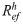
Estimation of Model FD in Period 3 (October/2004—September/2008).(a) observed incidence (O) and adjusted i (E), (b) m3/m, (c) Refh (h) and Refm (m), and (d) Ref=Refh×Refm.